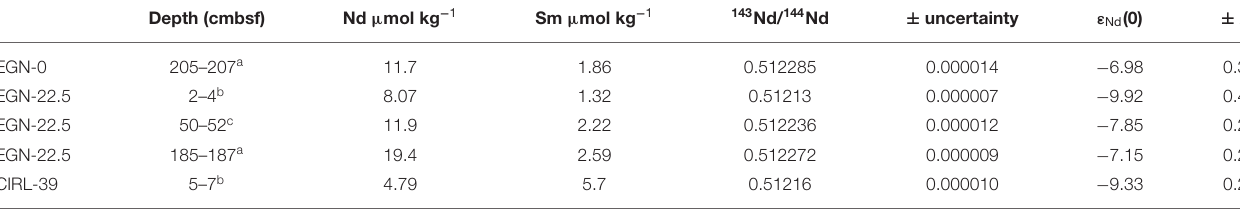
TABLE 2 | Neodymium isotope data for sediments from the Indian River Lagoon system. Depth (cmbsf)